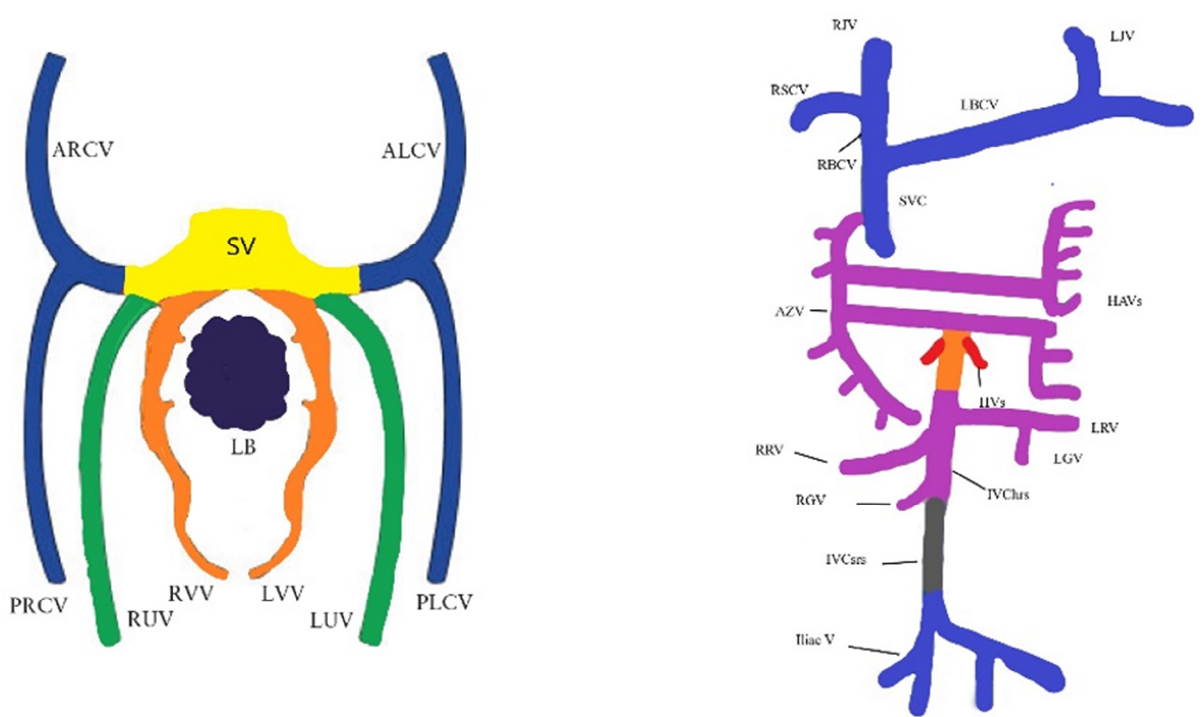
Figure 1. Schematic embryology of the venous system. ALCV, anterior left cardinal vein; ARCV, anterior right cardinal vein; AZV, azygos vein; HAVs, hemiazygos vein; HV(s), hepatic vein(s); Iliac V, iliac veins; IVC hrs, inferior vena cava hepatorenal segment; IVC srs, inferior vena cava sacrorenal segment; LB, liver buds; LBCV, left brachiocephalic vein; LGV, left gonadal vein; LJV, left jugular vein; LRV, left renal vein; LUV, left umbilical vein; LVV, left vitelline vein; PLCV, posterior left cardinal vein; PRCV, posterior right cardinal vein; RBCV, right brachiocephalic vein; RGV, right gonadal vein; RJV, right jugular vein; RRV, right renal vein; RSCV, right subclavian vein; RUV, right umbilical vein; RVV, right vitelline vein; SV, sinus venosus; SVC, superior vena cava. Ref. [3].